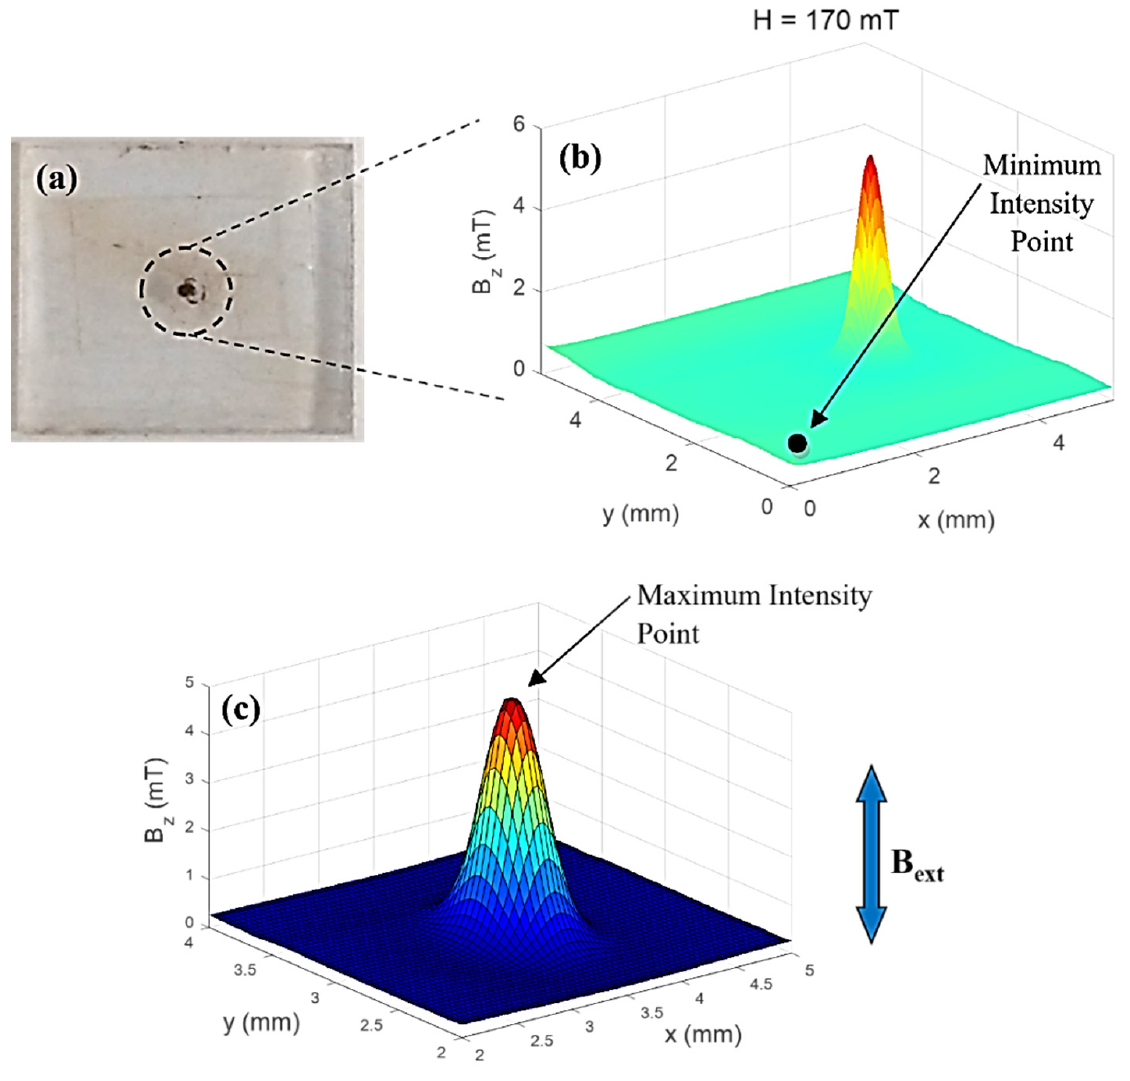
Figure 11. SMM measurements: ( a ) Sample holder made of acrylic; in the center, we can see the cylindrical cavity where the NP0 were placed. ( b ) Map Magnetic in 3D, with an applied magnetic field of 0.17 T. ( c ) Map Magnetic in 3D with grid where it is possible to verify the possibility of maximum intensity. The direction of external magnetic field is displayed.